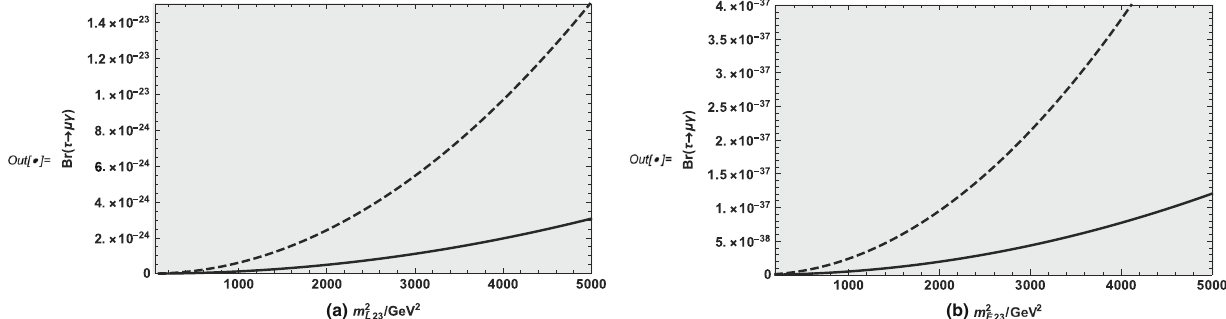
Fig. 9 Below the experimental limit, the line diagram of parameters and Br (τ → μγ) . In a , b solid lines and dotted lines represent tan β = 9